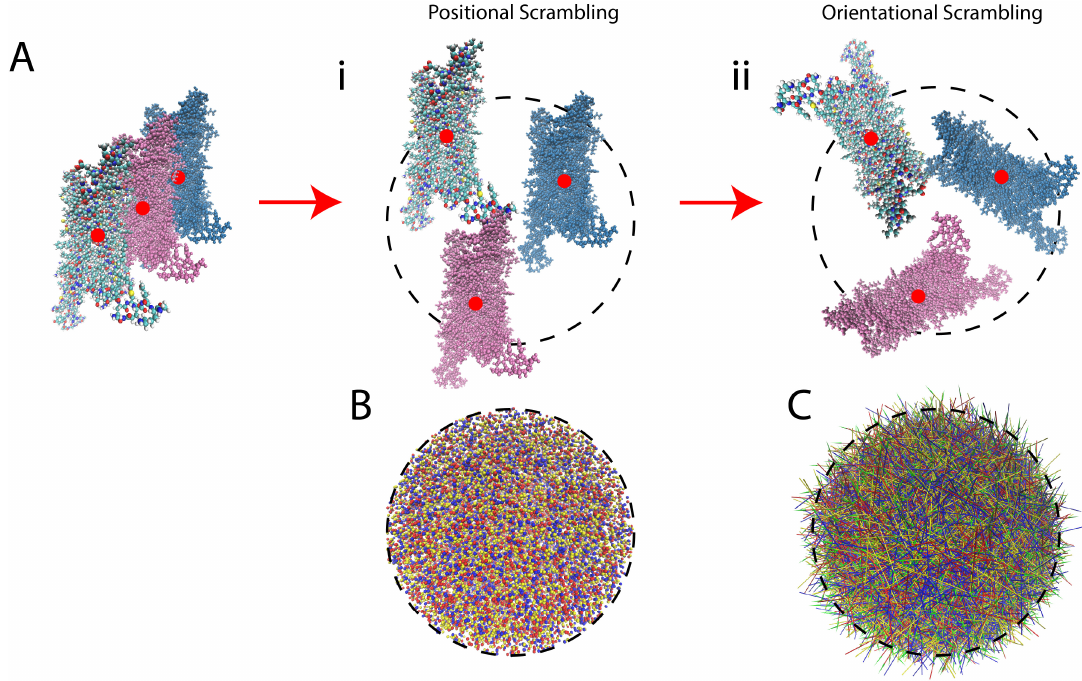
Figure 3. Illustration of the protocol for scrambling the frames of the MD trajectories. ( A ) Panel i Illustrates the positional scrambling of frames from a trajectory (depicted by the colored versions of the protein) by moving the centers of mass (red dots) to a randomly sampled coordinate within a sphere of diameter 90 Å (the size of the largest dimension of the receptor, indicated by the dashed circle). Panel ii Illustrates the orientational scrambling of the receptor by aligning a vector defined by two arbitrarily chosen atoms (preferably on an axis connecting the intracellular and extracellular ends of the GPCR) to a random unit vector in spherical coordinates. (Note: for the 5-HT2 A R, the two atoms chosen were atoms 3695 and 4346, which are the eta hydrogen (H η ) of K6.32 and one of the delta hydrogens (H δ ) of L7.34, respectively). ( B ) Illustrates the arbitrary positioning in space of the frames belonging to di ff erent trajectories of di ff erent receptor-ligand complexes, by showing the center of mass of the first 1000 frames of arbitrarily-chosen trajectories from each class. Frames from a full agonist-bound trajectory are in blue, from partial agonist-bound are yellow, from inverse agonist-bound are red. ( C ) Illustrates the arbitrary orientation of the frames from the di ff erent trajectories: green-tipped arrows with shafts going through atoms 3695 and 4346 are colored by the same color scheme as in B , and drawn for each of the first 1000 frames of the same trajectories as in panel B .